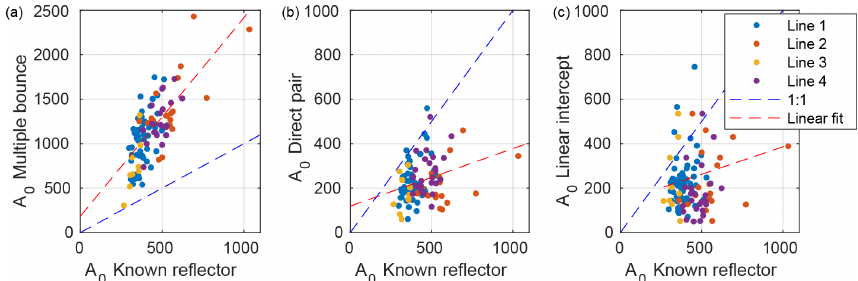
Figure 5. A 0 estimate comparisons. (a) A 0 estimates from known reflector method against A 0 estimates from multiple-bounce method (coefficient of determination ( r 2 ) of linear regression = 0 . 46). (b) A 0 estimates from known reflectivity method against A 0 estimates from the direct pair method ( r 2 = 0 . 09). (c) : A 0 estimates from known reflector method against A 0 estimates from linear intercept method ( r 2 = 0 .